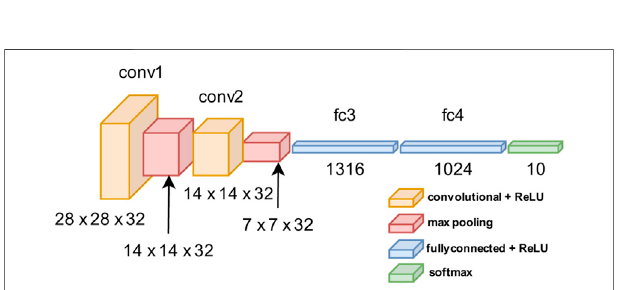
FIGURE 5 | Architecture of neural network for